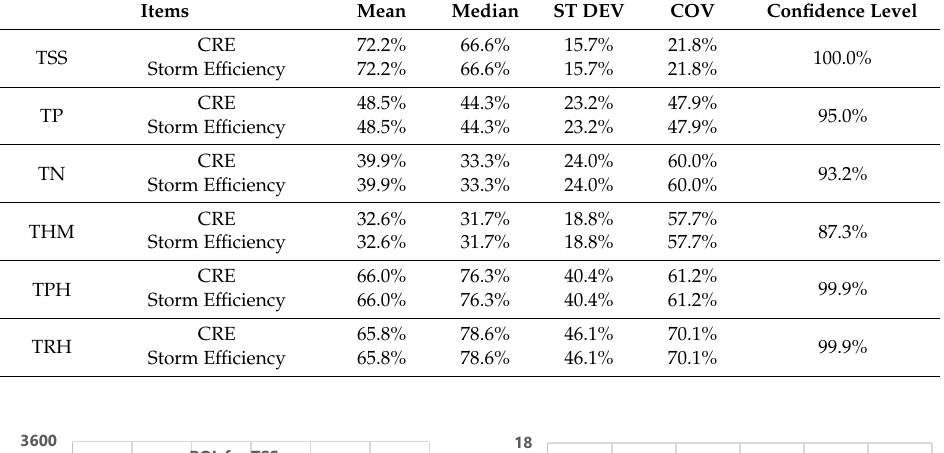
y = 0.2583x R² = 0.3351